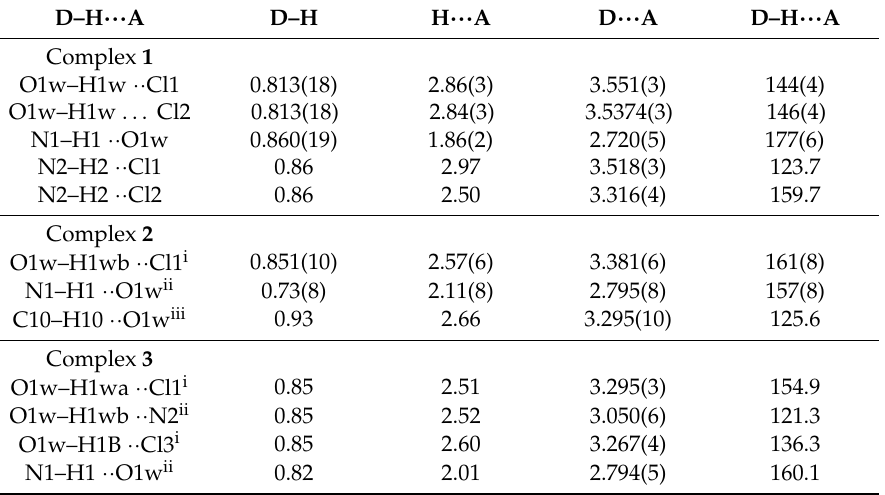
Figure 6. Hydrogen-bonded motifs and the packing graphic for complex 3 . Hydrogen bonds are shown as dashed lines. Table 2. Geometries of the hydrogen bond lengths and bond angles in 1 – 3 (Å, ◦